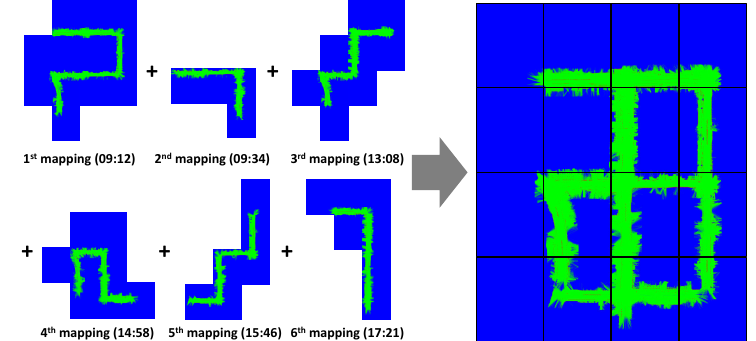
Figure 11. Cloud update of the multiple EOGM tiles for the different areas at different times. EOGM tiles of six test mapping are uploaded and merged into EOGM tiles in the